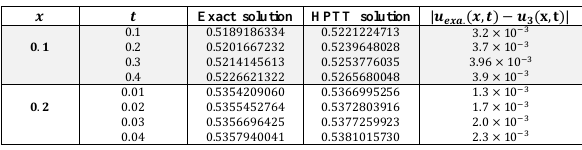
Table 2: Absolute errors for differences between the exact solution and 3 rd order HPTT solution for diverse values x and t when ρ = 0.45, β = 0.5 , for Ex.